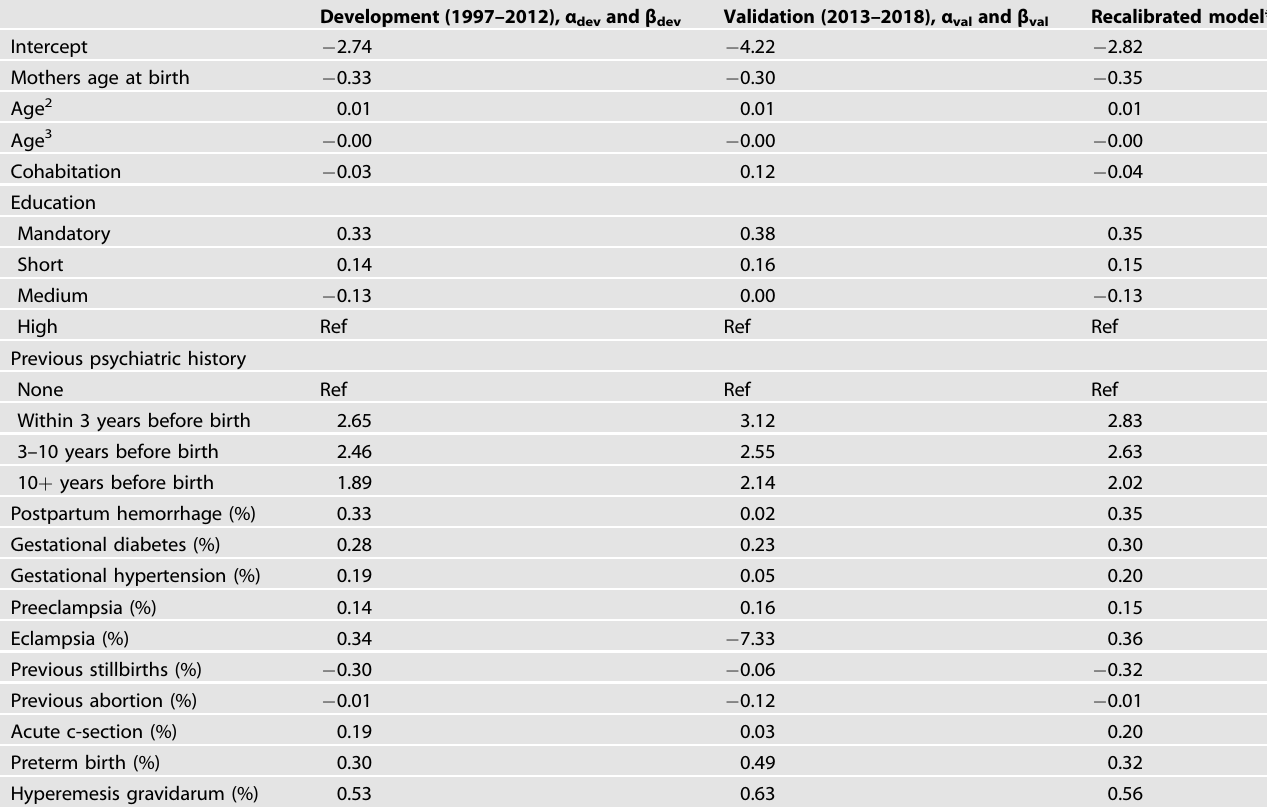
Table 4. Coef fi cients in the Extended